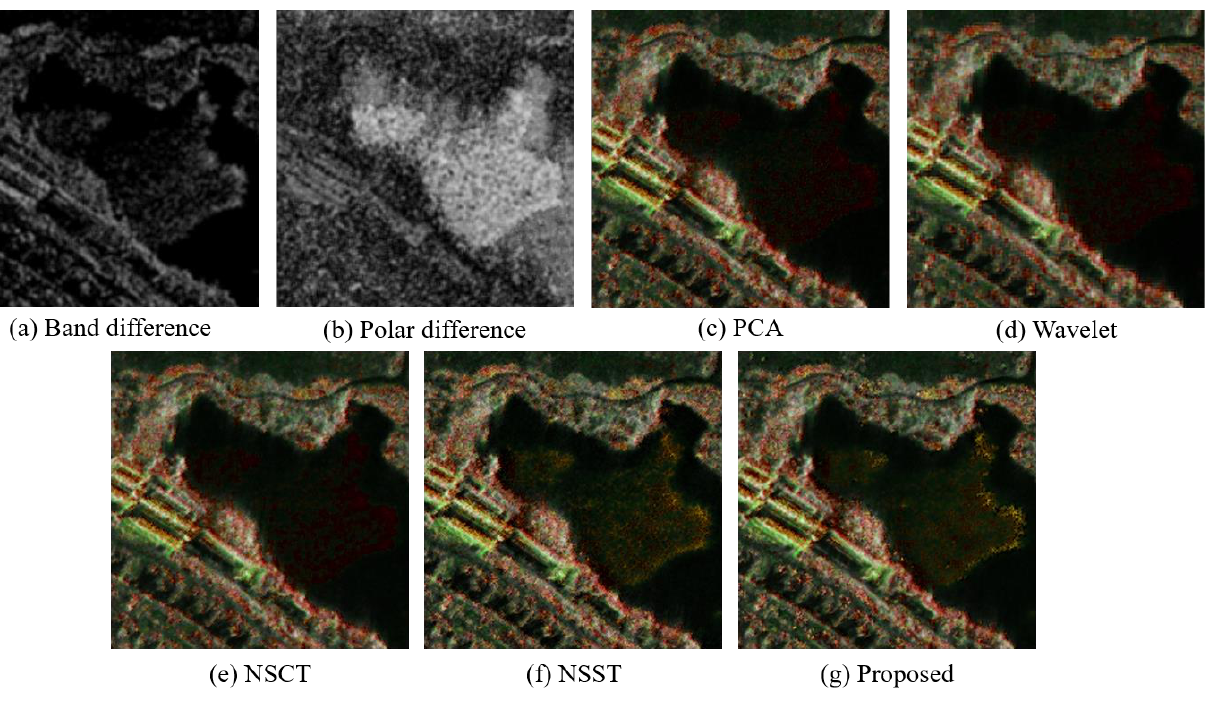
Figure 10. Band difference map, polarization difference map, and colorized fusion results of special region in scene 2: ( a ) Band difference map; ( b ) polarization difference map; ( c ) colorized PCA fusion; ( d ) colorized wavelet fusion; ( e ) colorized NSCT fusion; ( f ) colorized NSST fusion; and ( g ) colorized proposed method fusion.